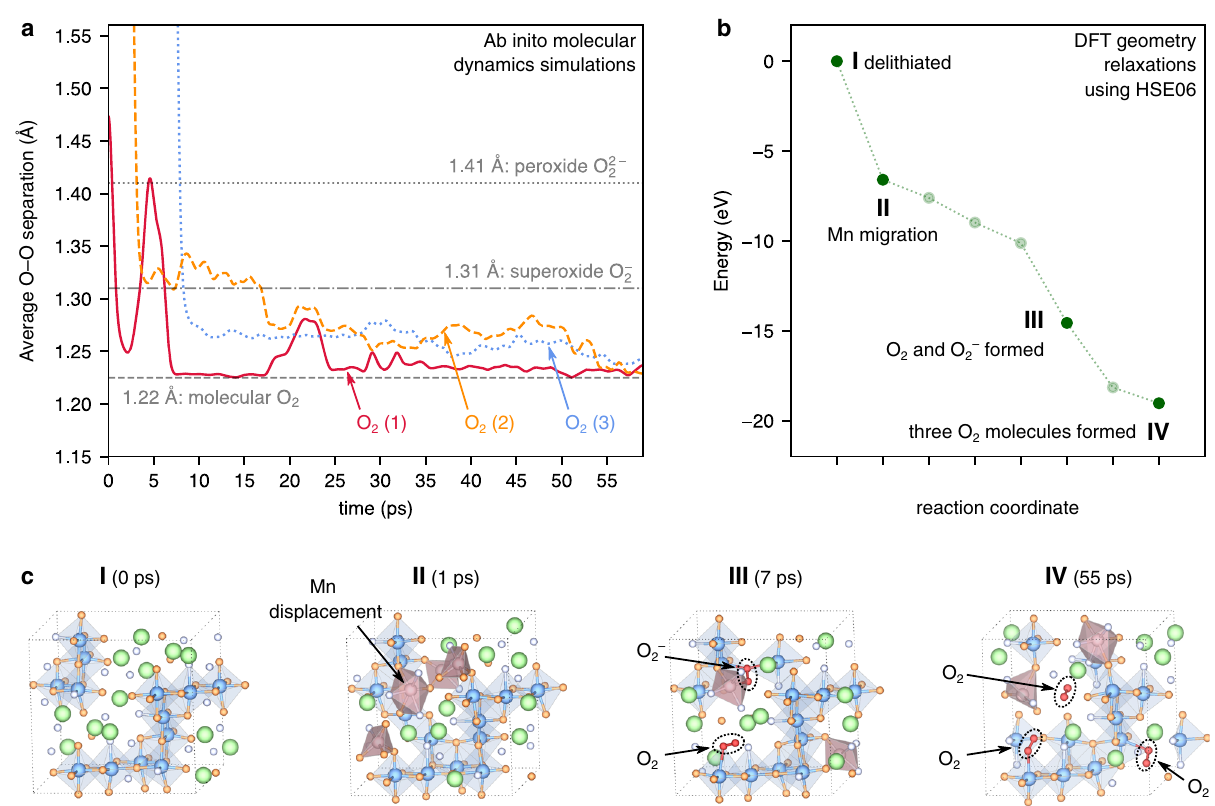
Fig. 4 | Reaction mechanism to form O – O dimers in Li 0.67 MnO 2 F from ab inito molecular dynamics (AIMD) and geometry relaxations. a O···O interatomic separation of O species forming O – O dimers from GGA+ U AIMD simulations at 500K. b TotalenergyofselectedstructuresalongtheAIMDtrajectory,fullyrelaxed